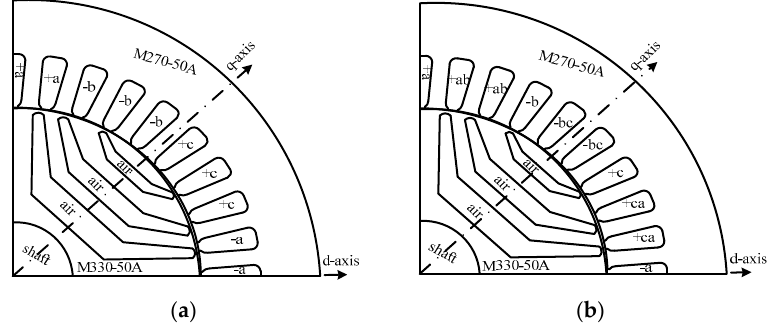
Figure 2. Phasor diagram of magnetomotive forces (MMFs) produced by star and combined star– delta windings. ( a ) Star connection; ( b ) Combined star–delta connection.